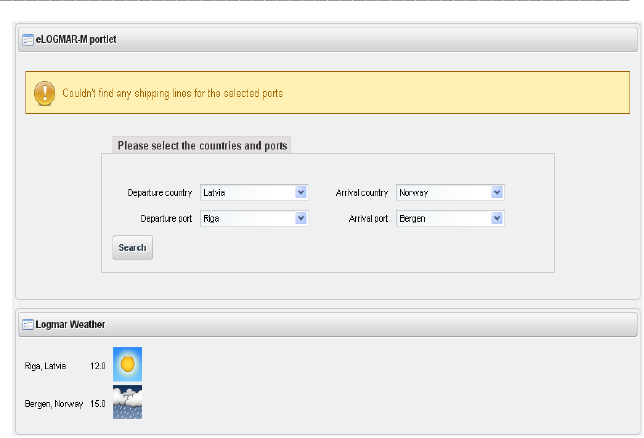
Fig. 3. Inter-portlet communication between shipping line services and weather portlets. Special web service was created to communicate with a railway portal and to integrate the calculation of block train freight prices into www.einterasia.com tariff calculation algorithms (Fig. 4).